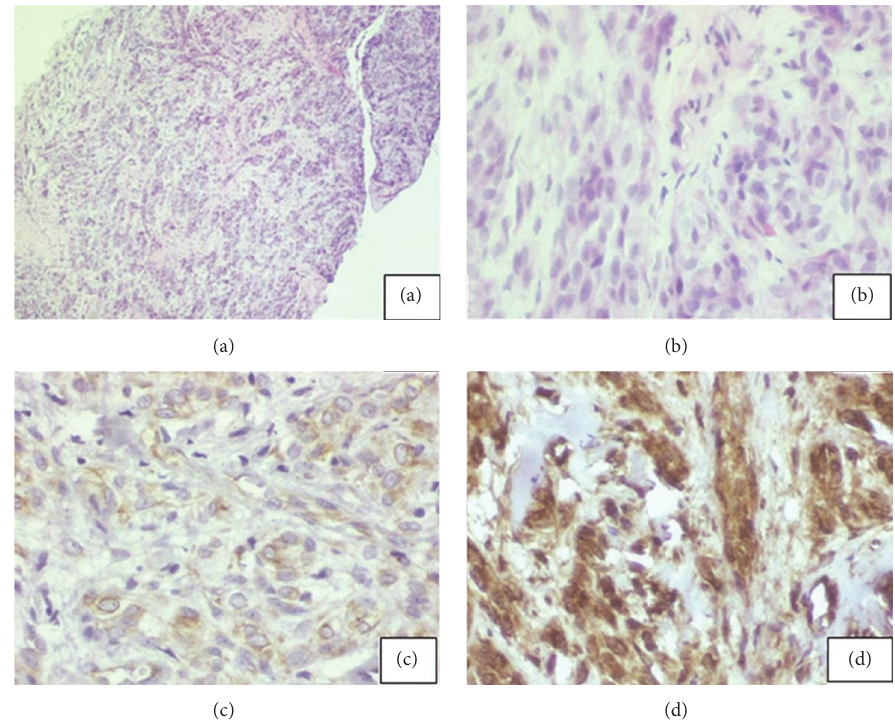
Figure 2: (a) Cell bundle arrangements with rounded, large nuclei that sometimes contain palisades, strands, and/or hyalinized islands. Hematoxylin and eosin (HE) staining, 40x. (b) Spindle cells with comma-shaped nuclei. HE staining, 100x. (c) Cells positive for S-100 protein. IHC, 200x. (d) Cells positive for glial fibrillary acidic protein (GFAP). IHC,